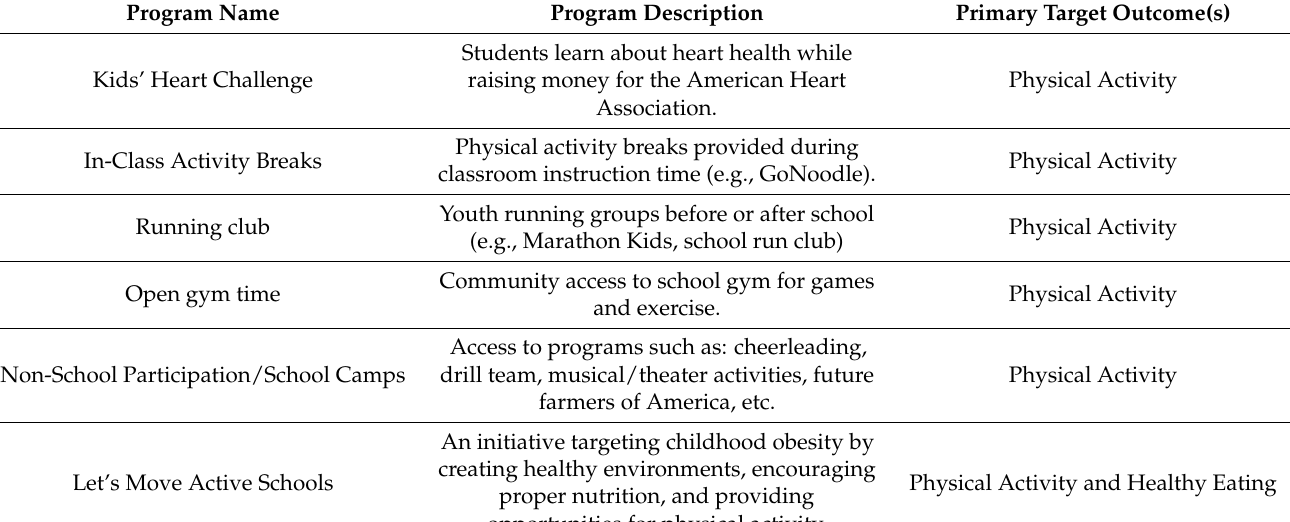
Table 2. Programs and activities that were part of the Healthy Zone Schools